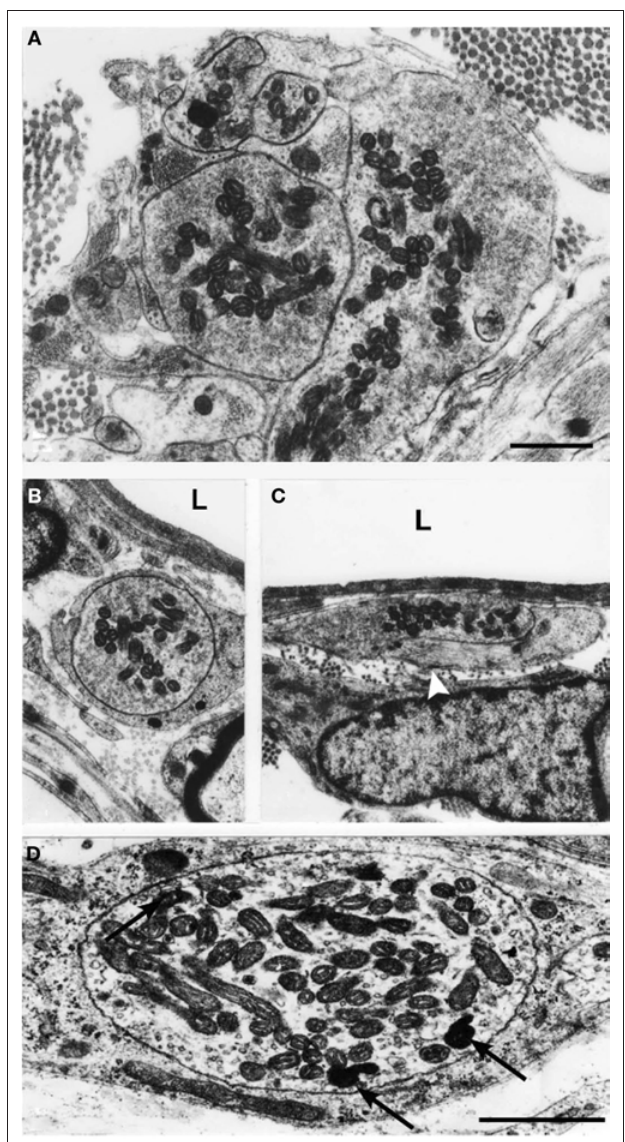
Figure 4 | electron micrographs showing a thin section from the CNS–PNS border of a cat, 90 days after sciatic nerve resection. A number of large unmyelinated axons filled with mitochondria and vesicles were observed at the PNS/CNS border (A) and in the pia mater (B–D) . The axons shown in (B,C) had a perivascular location. The axon profile in (C) is only invested partly by a basal lamina (white arrowhead). In most cases, the content of vesicles was heterogeneous. The lumen of the blood vessels is indicated by “L.” The axon shown in (D) contained electron lucent vesicles as well as a number of dense cored vesicles (arrows) (magnification in A–C ). Scale bars = 0.5